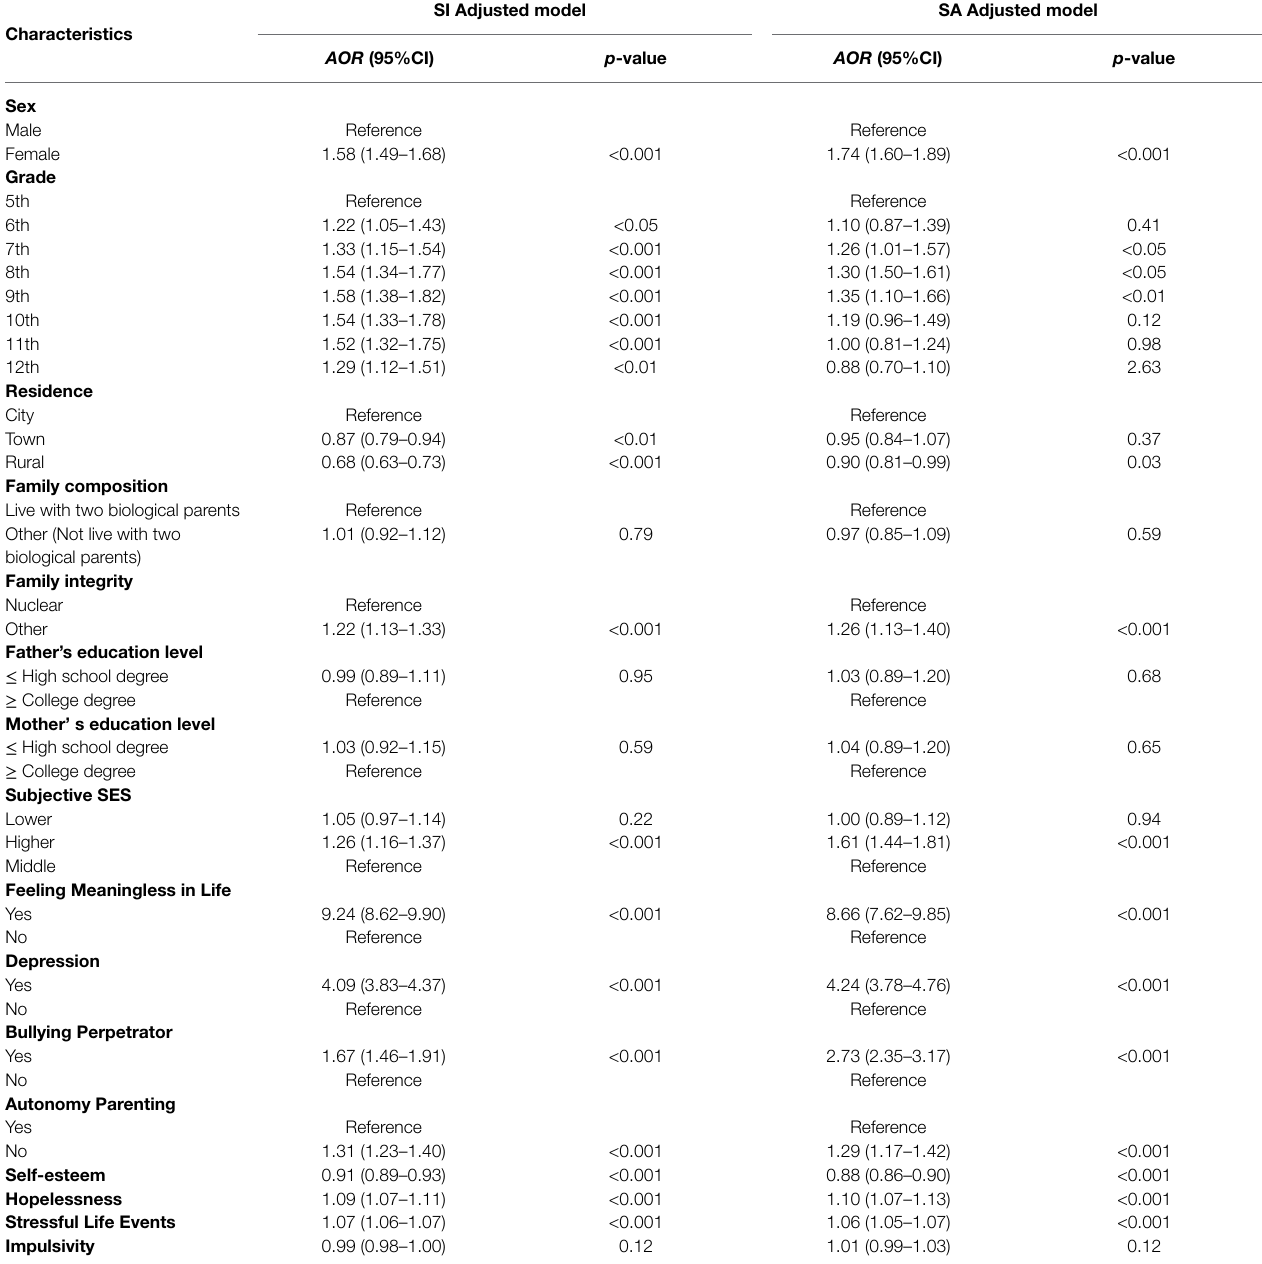
TABLE 3 | Multivariable logistic regression analysis of risk factors for SI and SA.